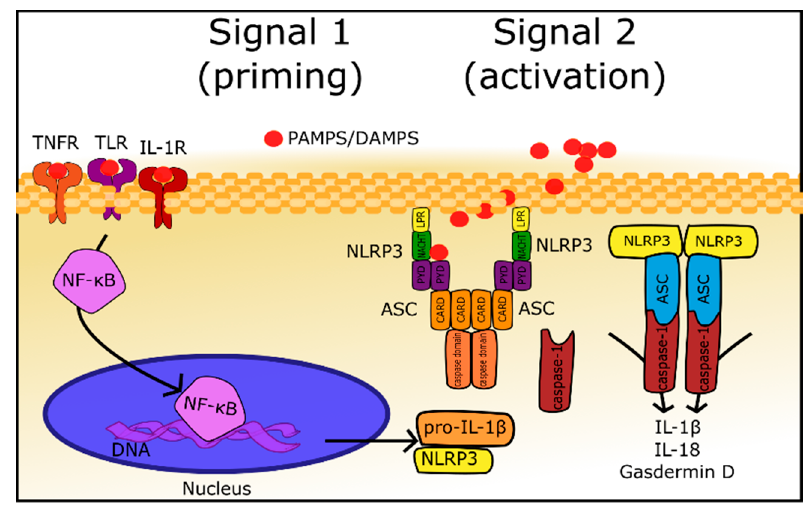
Figure 1. Mechanism of the formation and activation of the NLRP3 inflammasome (detailed